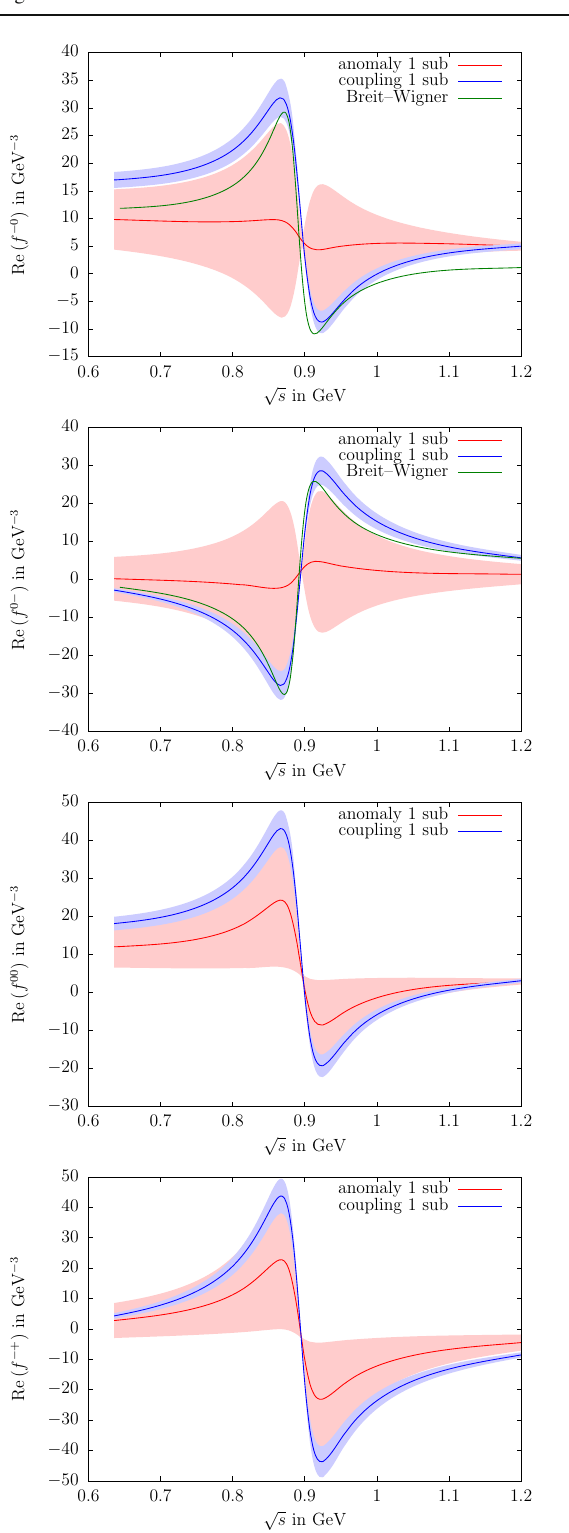
Fig. 6 Results for γ K − → K − π 0 , γ K − → ¯ K 0 π − , γ ¯ K 0 → ¯ K 0 π 0 , and γ ¯ K 0 → K − π + P -wave amplitudes (from top to bottom) in the minimal subtraction scheme, matched to the chiral anomaly and the K ∗ radiative couplings separately. Left and right panels show real and